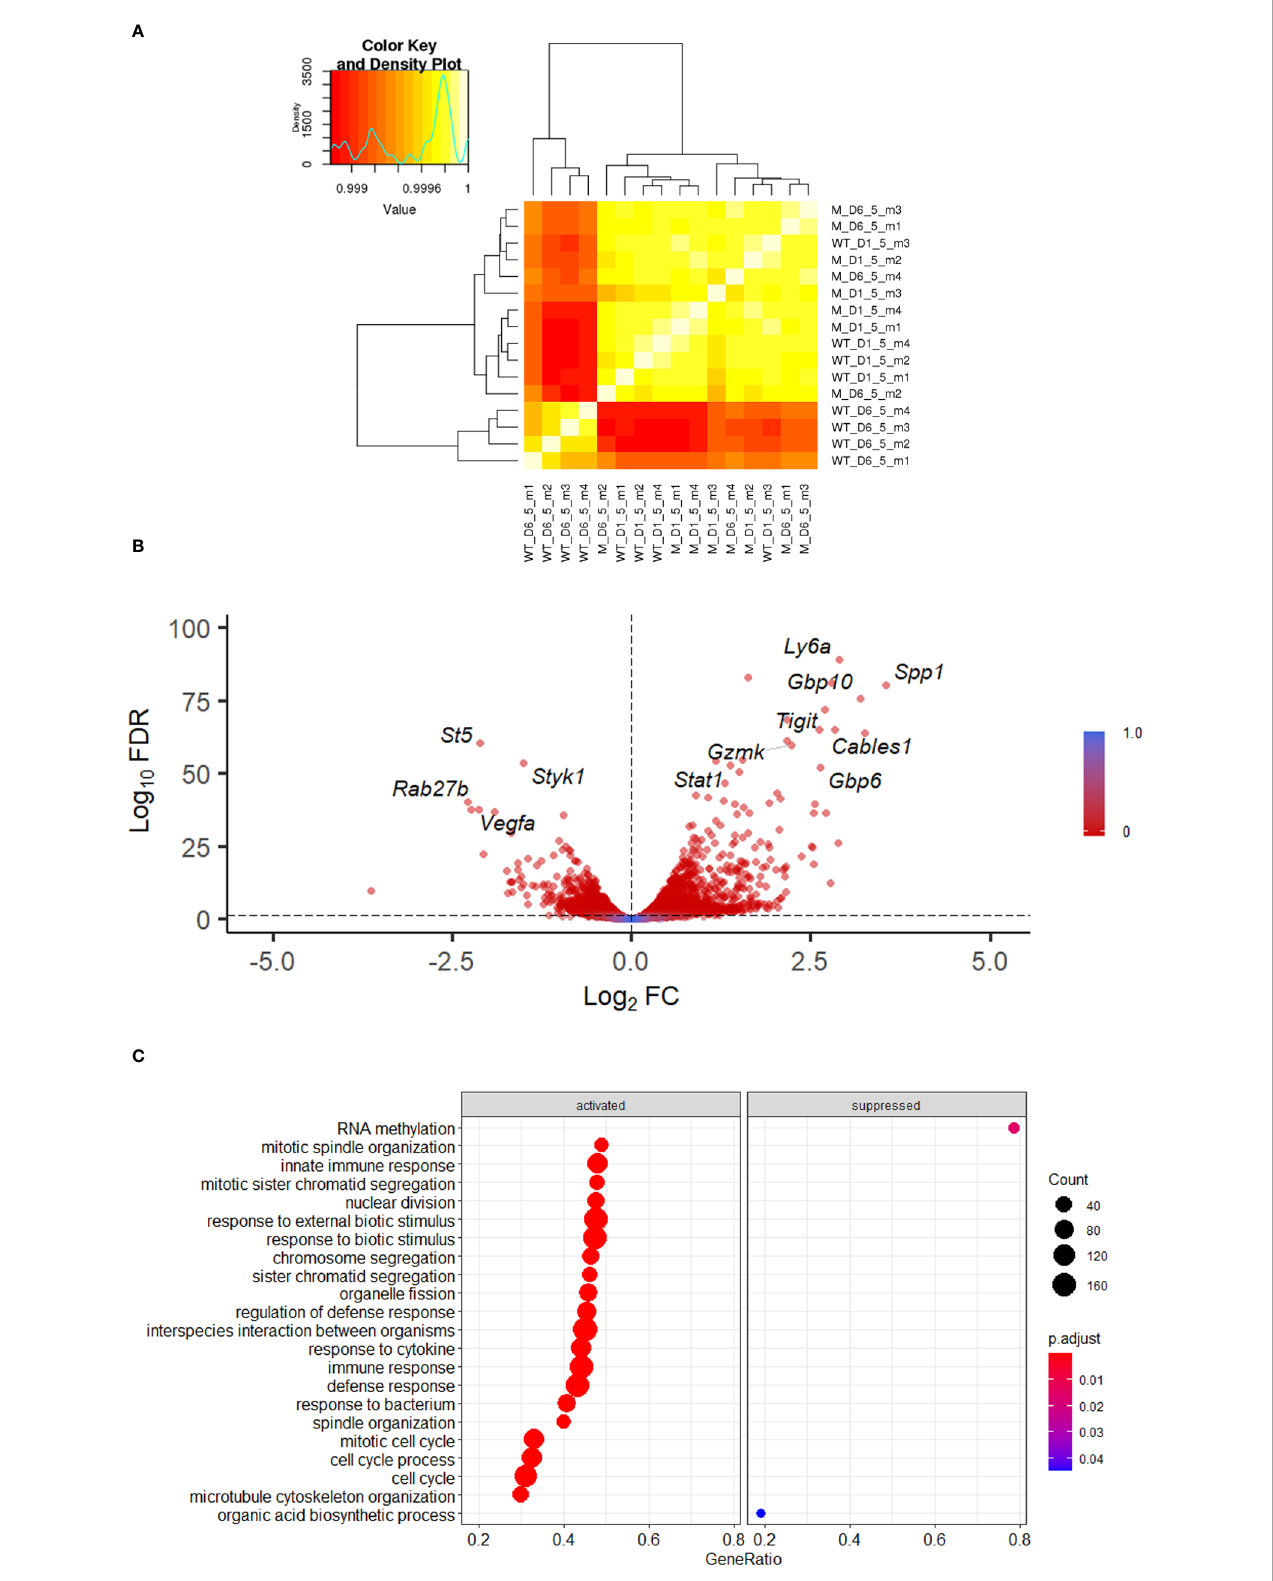
FIGURE 2 Transcriptomic analysis of splenic NK cells following VACV infection. C57BL/6 mice ( n =4) were infected i.n. with WT VACV or were mock-infected with vehicle control for 1.5 or 6.5 d and the transcriptome of splenic NK cells was analysed by RNA-seq. (A) Clustering analysis heatmap representing correlations among the 16 RNA-seq samples. The intensity of the cell colour corresponds to the degree of correlation between the compared groups. “ WT ” represents infected mice, “ M ” the mock-infected mice. (B) Volcano plot of NK cell transcripts differentially expressed at 6.5 d.p.i. in VACV-infected mice compared to mock. Each DEG (FDR<0.05) (WT vs mock) is represented by a red dot. (C) Gene ontologies for biological process enrichment amongst DEGs (FDR<0.05) in NK cells from infected mice (VACV 6.5 dpi vs